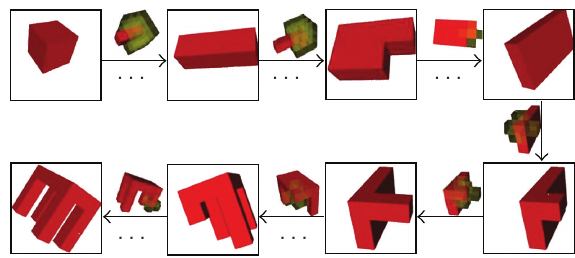
Figure 7: The constructing process of a stool model.